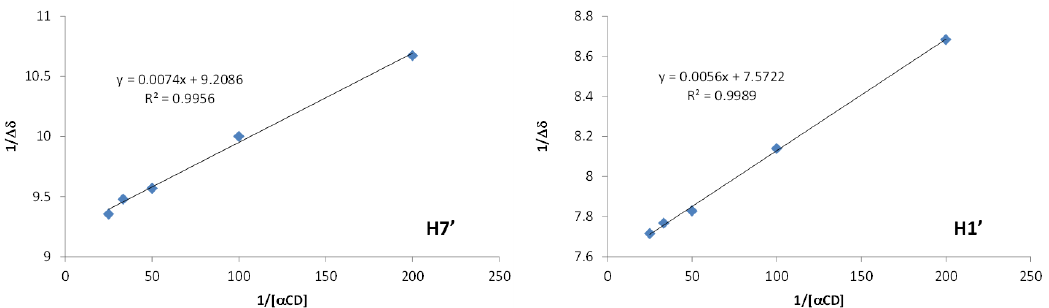
Figure 9. Benesi–Hildebrand Plots for protons of MOR (600 MHz, D 2 O, 300 K, 0.2 mM) in the presence of α-CD. of α